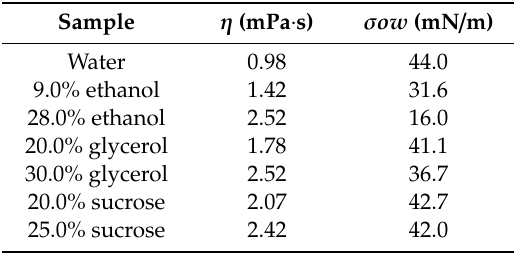
Table 4. Viscosity and interfacial tension with hexadecane at 20 ◦ C.